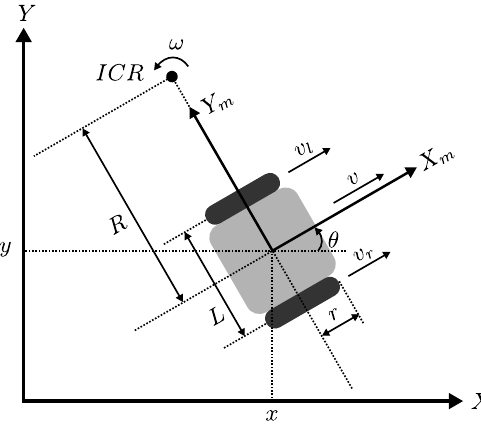
Figure 1. The differential drive mobile